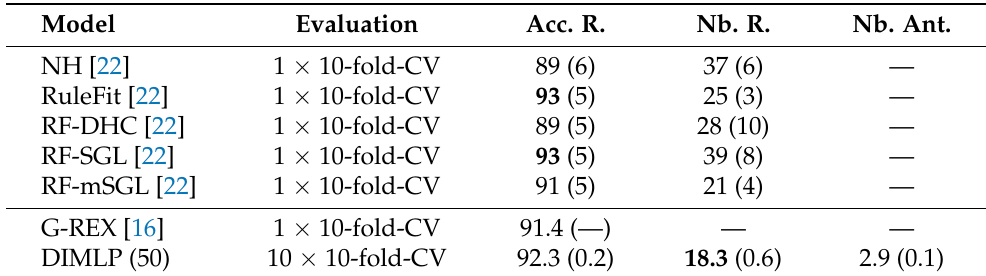
Table 14. Other results on the “Ionosphere” dataset. A bold number represents a highest average accuracy of the rules.